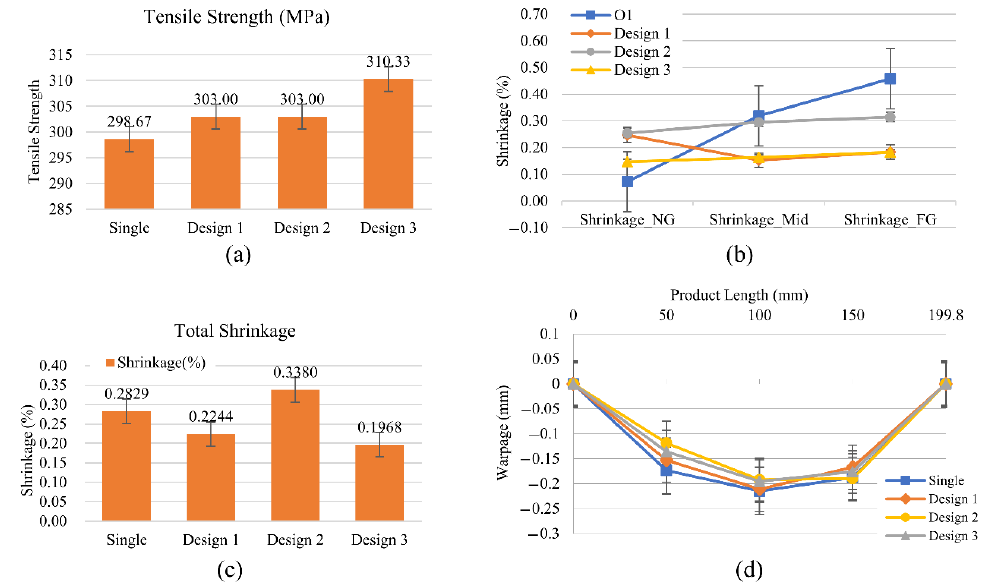
Figure 15. ( a ) Tensile strength, ( b ) regional deviation of shrinkage, ( c ) total shrinkage, and ( d ) warpage.